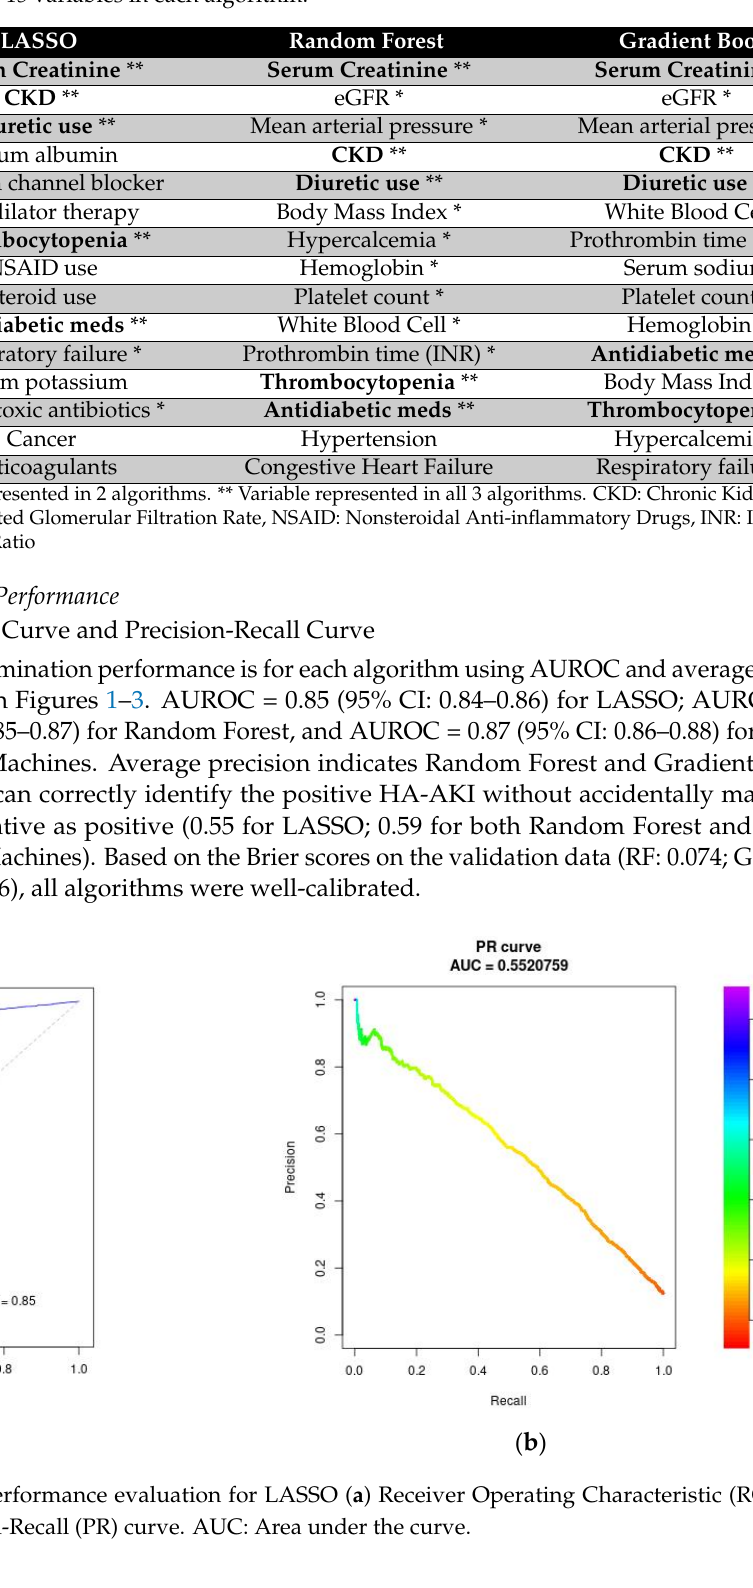
Table 3. Top 15 variables in each algorithm.